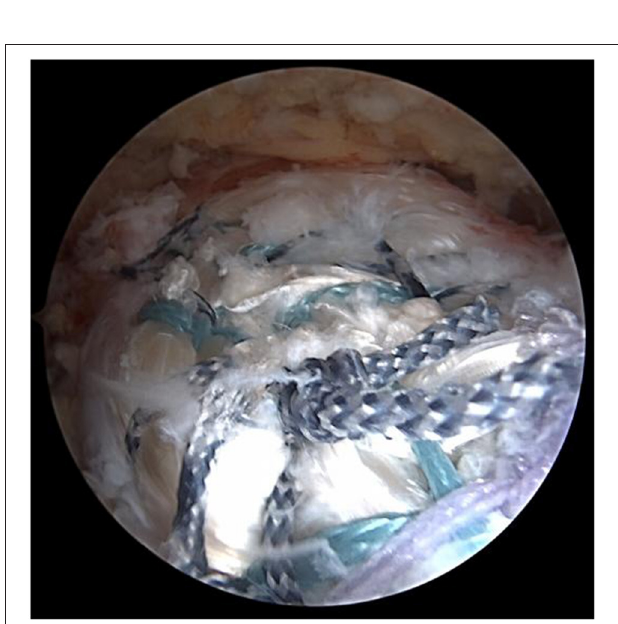
FIGURE 6 | The inner margin of the supraspinatus tendon and the tendon autograft were stitched together side by side if tension was allowed.